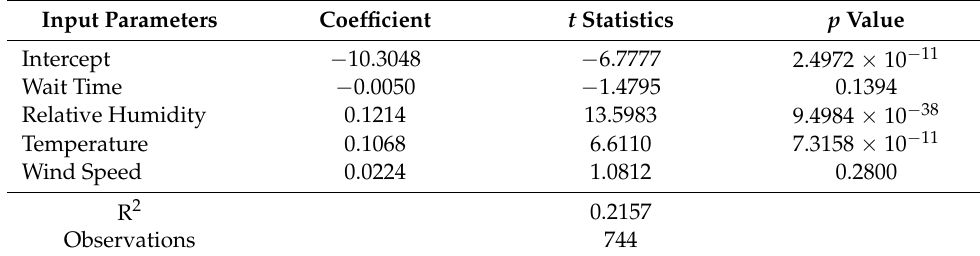
Table 3. Linear Regression